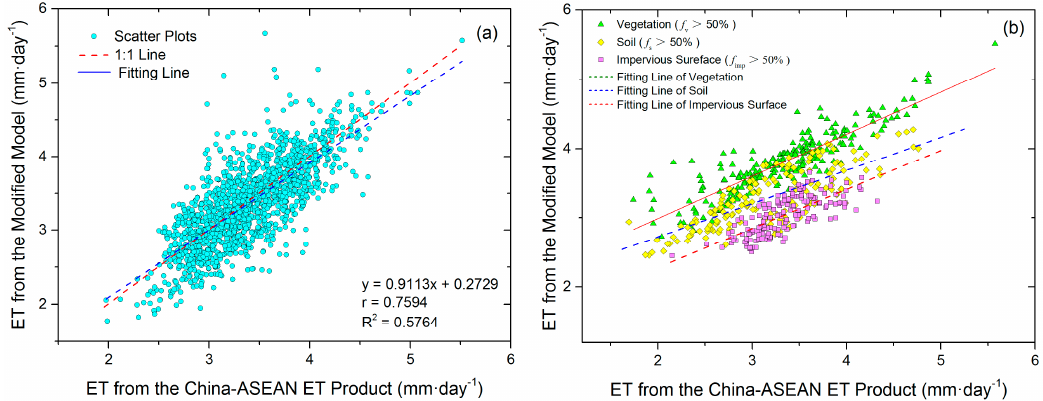
Figure 19. ( a ) Scatter plot of the modified model derived ET against the China–ASEAN ET product in Wuhan testing area, based on the entire 1446 sampled points; ( b ) scatter plot of the modified model derived ET against the China–ASEAN ET product, for each land cover (229 sampled points for vegetation, 149 for soil and 160 for impervious surfaces).